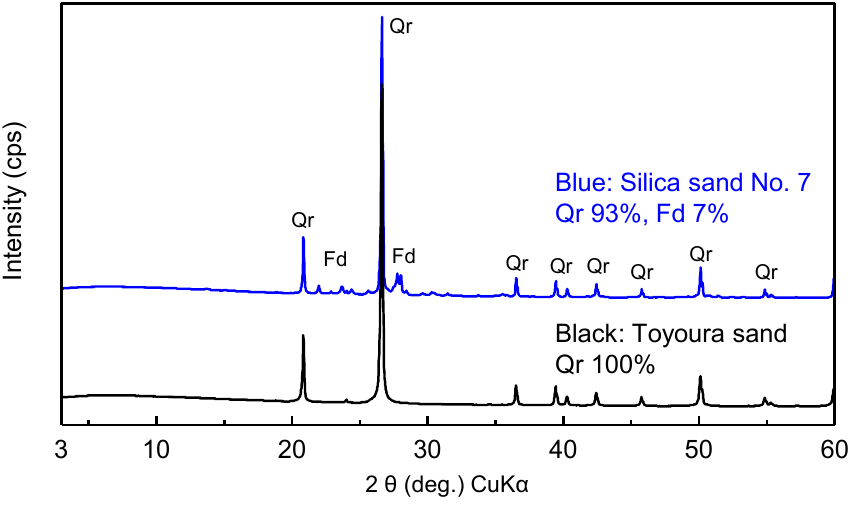
Figure 3. Results of powder X-ray diffraction of Toyoura sand ( black ) and silica sand No. 7 ( blue